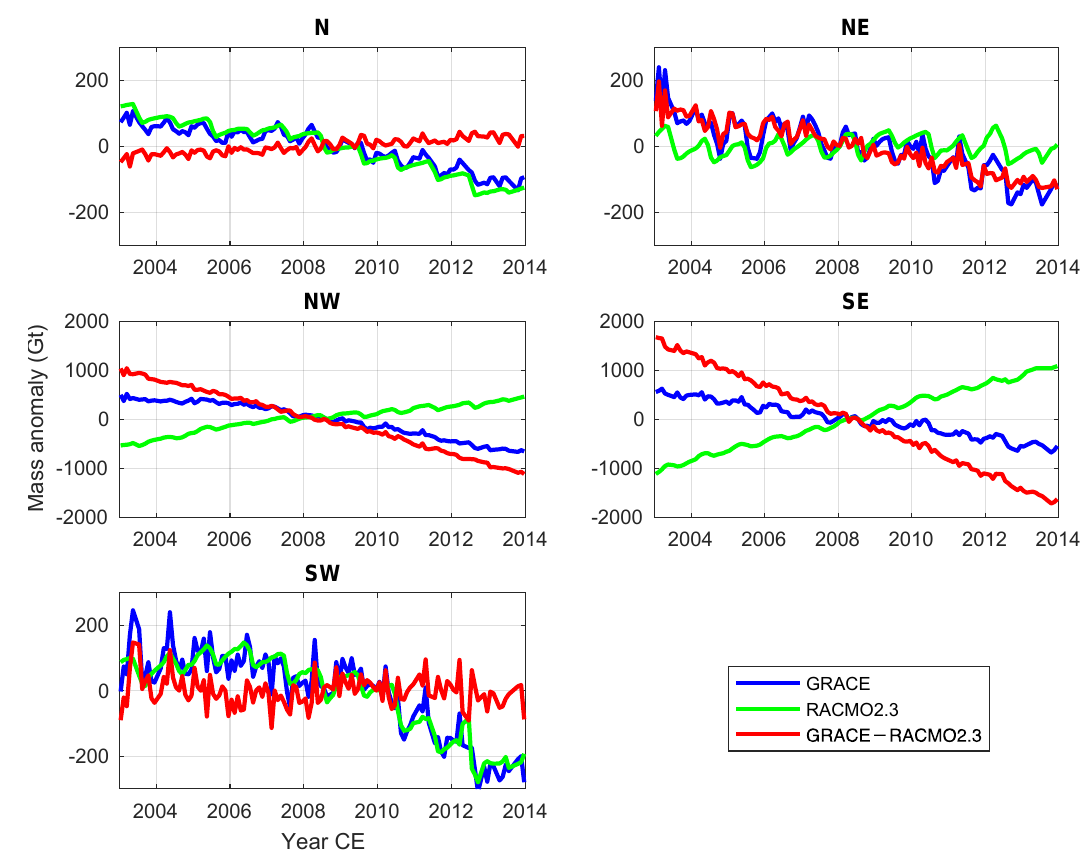
Figure A2. Same as Fig. 2 but for the GRACE-based estimates produced with data weighting at the drainage system scale. The estimates produced without data weighting are not shown as they are very similar to those with data weighting.